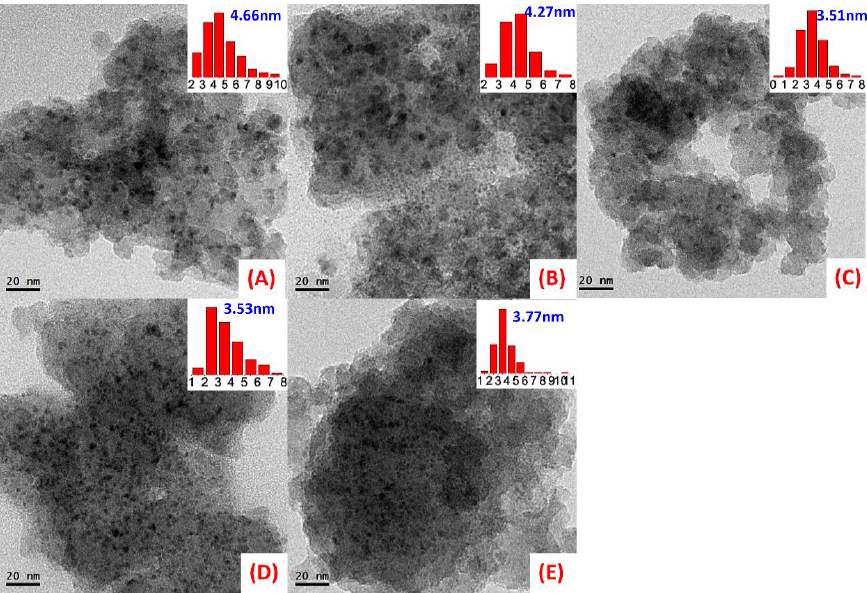
Figure 2. TEM images of reduced samples: ( A ) Cu/SiO 2 , ( B ) 0.04E-Cu/SiO 2 , ( C ) 0.08E-Cu/SiO 2 , ( D ) 0.12E-Cu/SiO 2 , ( E ) 0.3E-Cu/SiO 2 .